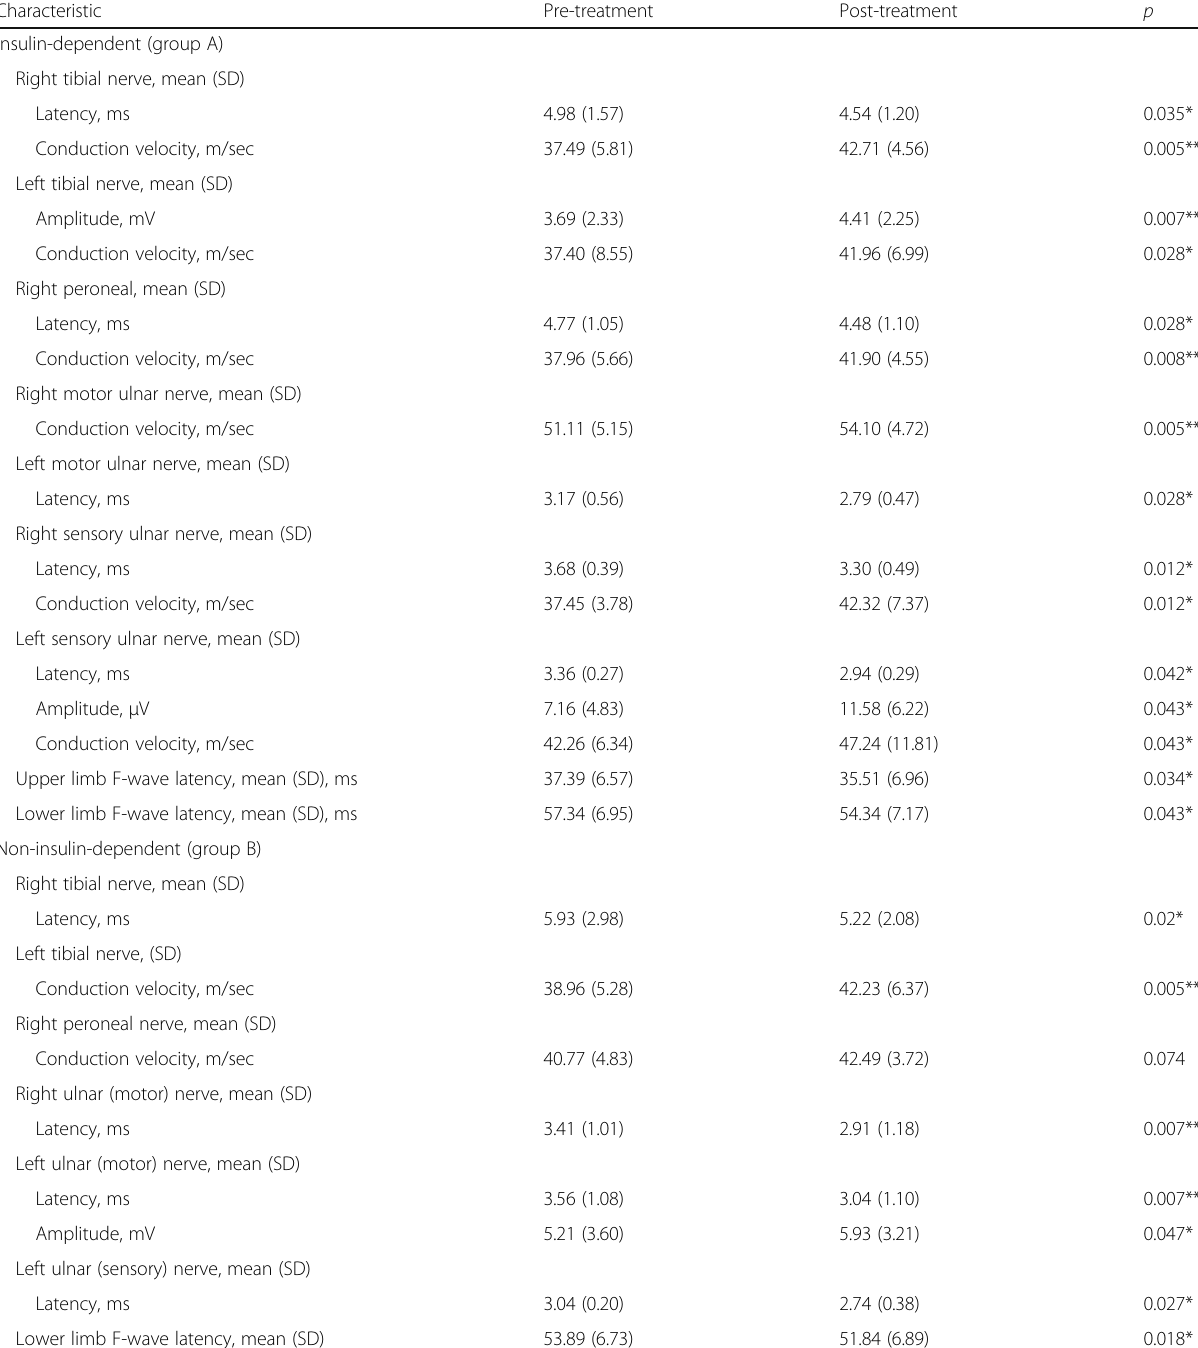
Table 3 Nerve conduction parameters prior to and following